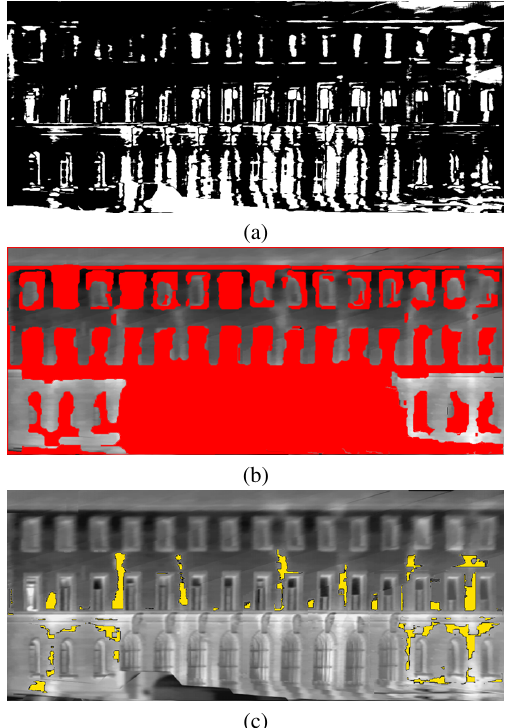
Figure 10. Leakage detection a) Disparity from difference tex- ture of textures from forward and backward view. b) Mask after post processing with region growing and morphological opera- tors. All windows are masked out. c) Marked leakages (yellow) overlayed the original texture. Windows and other 3d objects are not detected as leakages. Most of the heating pipes are detected as